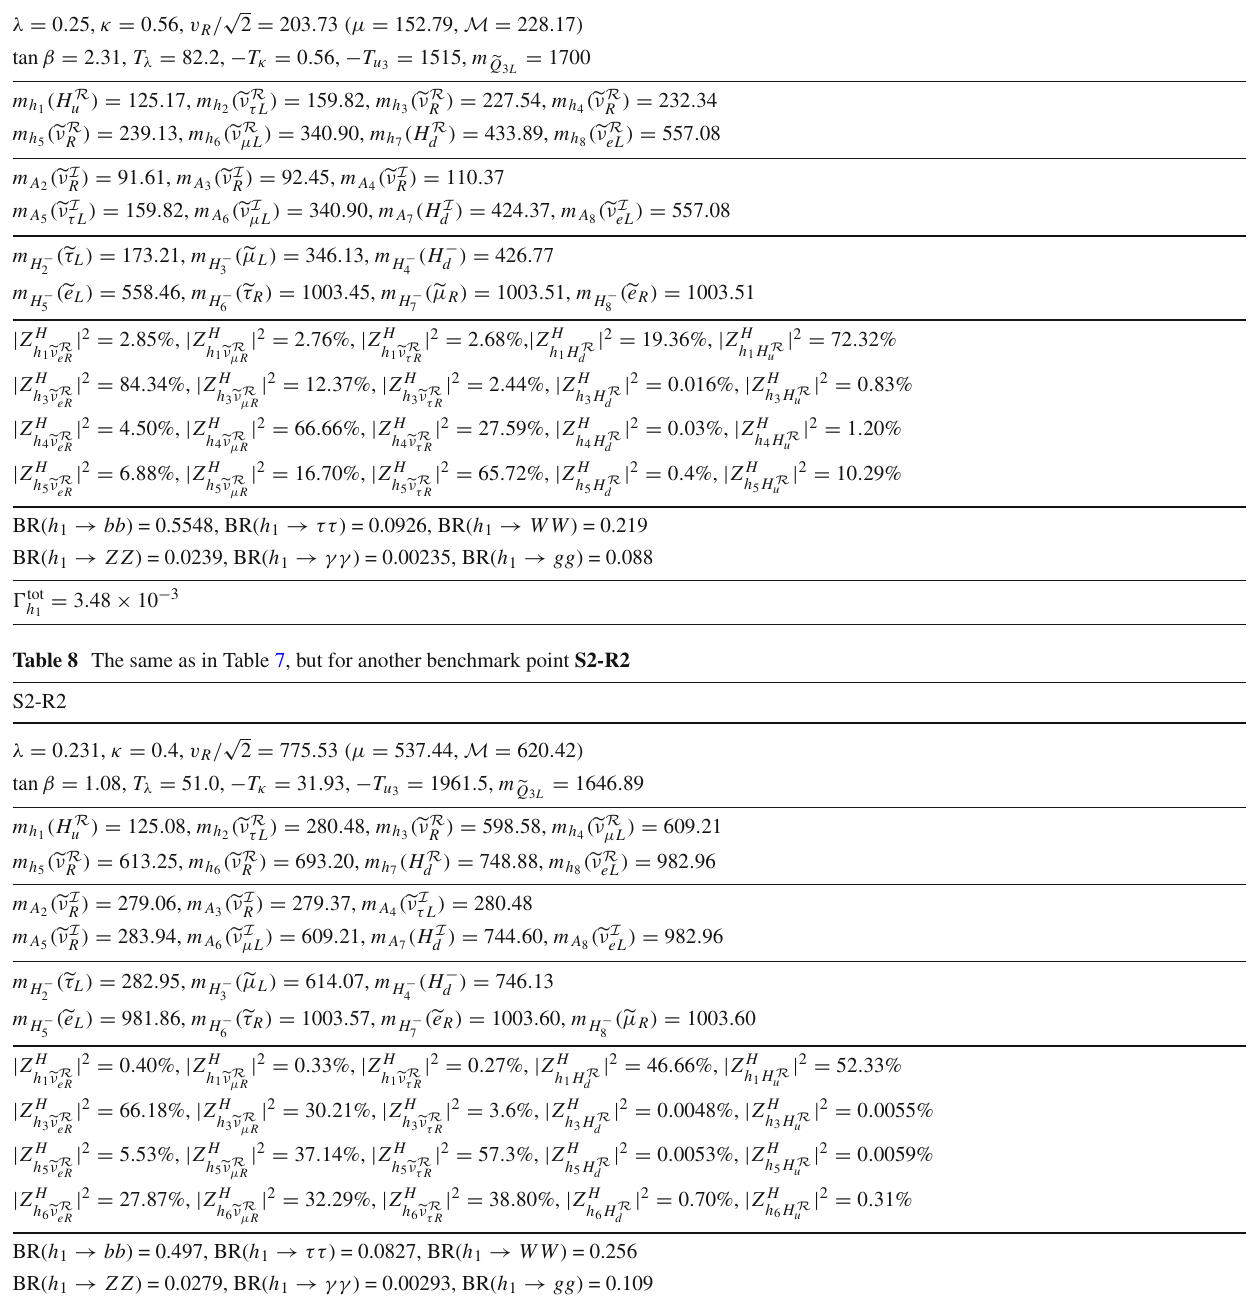
Table 7 Benchmark point S2-R1 from scan S 2 , with the SM-like associating the first doscalars by A 2 ,..., 8 and charged Higgses by H − 2 ,..., 8 Higgs h 1 being the lightest scalar. Input parameters at the low scale states to the Goldstone bosons eaten by the Z and W ± . Their dominant M EWSB are given in the first box, where we also show for complete- √ √ composition is written in brackets. For the case of the SM-like Higgs ness μ = 3 λv R / 2 and M = 2 κv R / 2 since their values deter- and singlet-like scalars their main compositions are broken down in the mine Higgsino and right-handed neutrino masses. Scalar, pseudoscalar fifth box. Relevant branching ratios for the SM-like Higgs h 1 are shown and charged Higgs masses are shown in the second, third and fourth in the sixth box. Its decay width is shown in the seventh box. VEVs, boxes,respectively.Scalarmasseigenstatesaredenotedby h 1 ,..., 8 ,pseu- soft parameters, sparticle masses and decay widths are given in GeV S2-R1